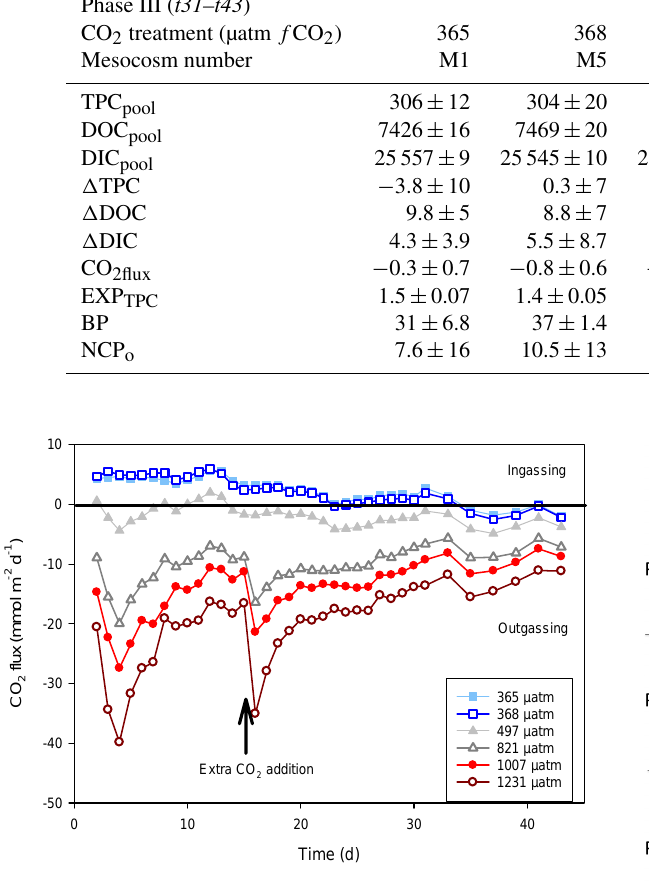
Fig 2 Figure 2. The calculated exchange of CO 2 between the mesocosms and the atmosphere. Positive values indicate net influx (ingassing), and negative values net outflux (outgassing) from the mesocosms. The flux was based on measurements of N 2 O as a tracer gas and calculated using Eqs. (2)–(5).